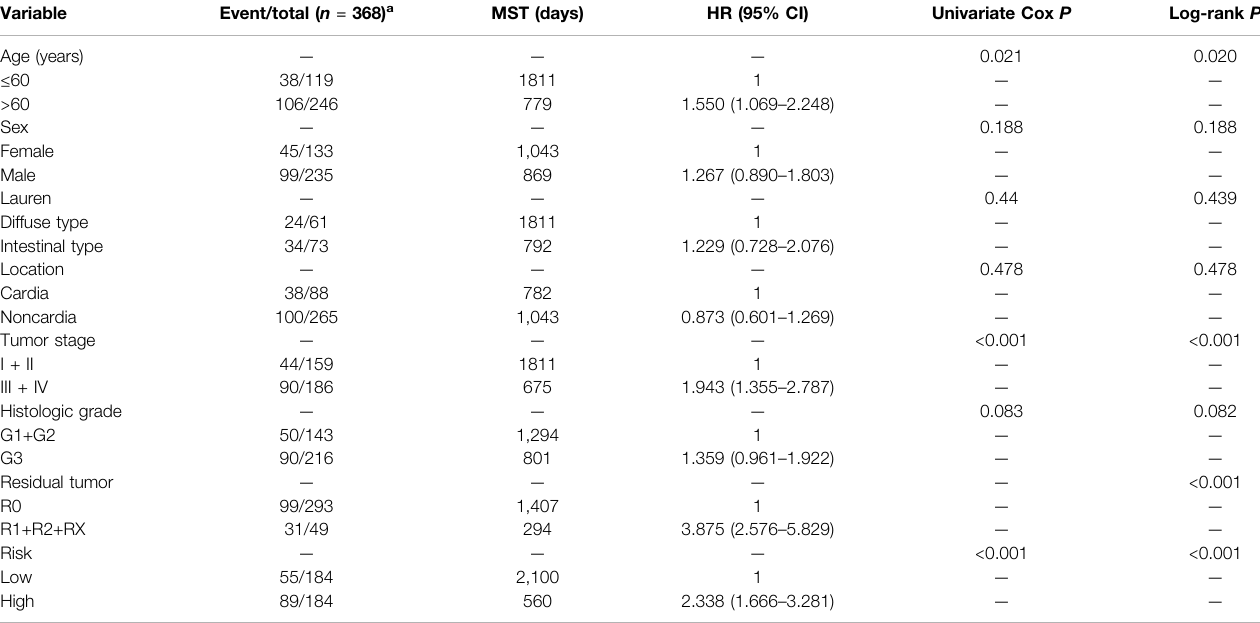
TABLE 2 | Distribution of gastric cancer patients ’ clinical characteristics and subsequent analysis of prognosis.